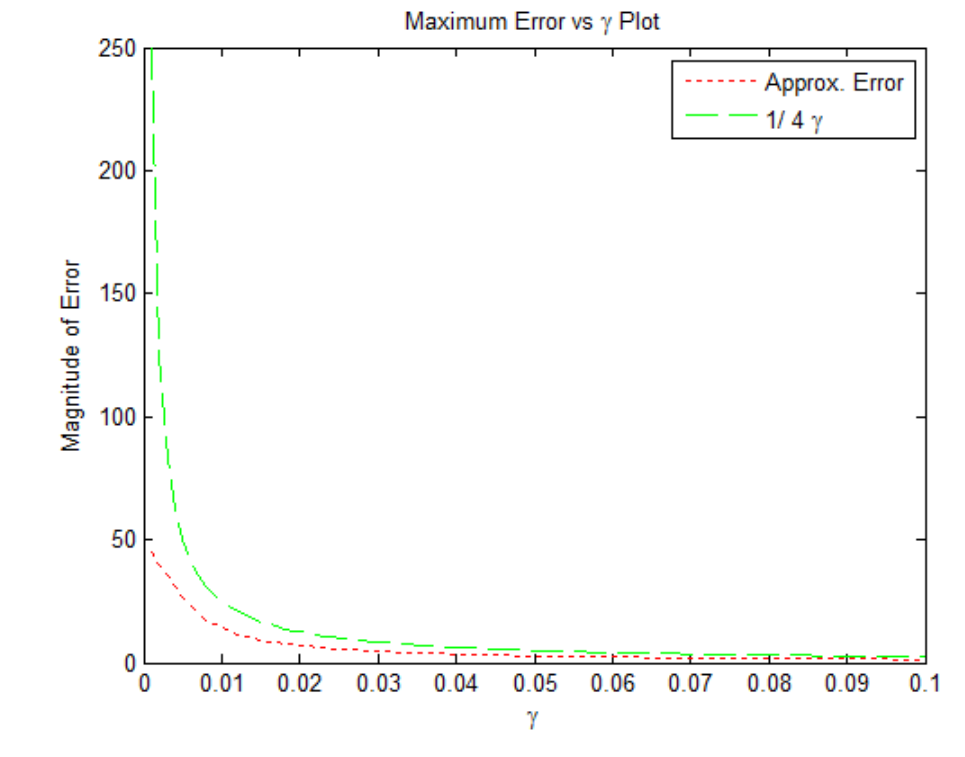
Figure 2. 𝒍 𝟏 norm approximation error bounds for 𝒛 > 𝟎 , the green line shows the upper bound proved mathematically in Equation (16), whereas the dotted red line shows the actual error between the proposed 𝒍 𝟏 norm smooth approximation and actual non-differentiable 𝒍 𝟏 norm. The error is maximum at approximately zero and approaches zero as 𝜸 → ∞ .